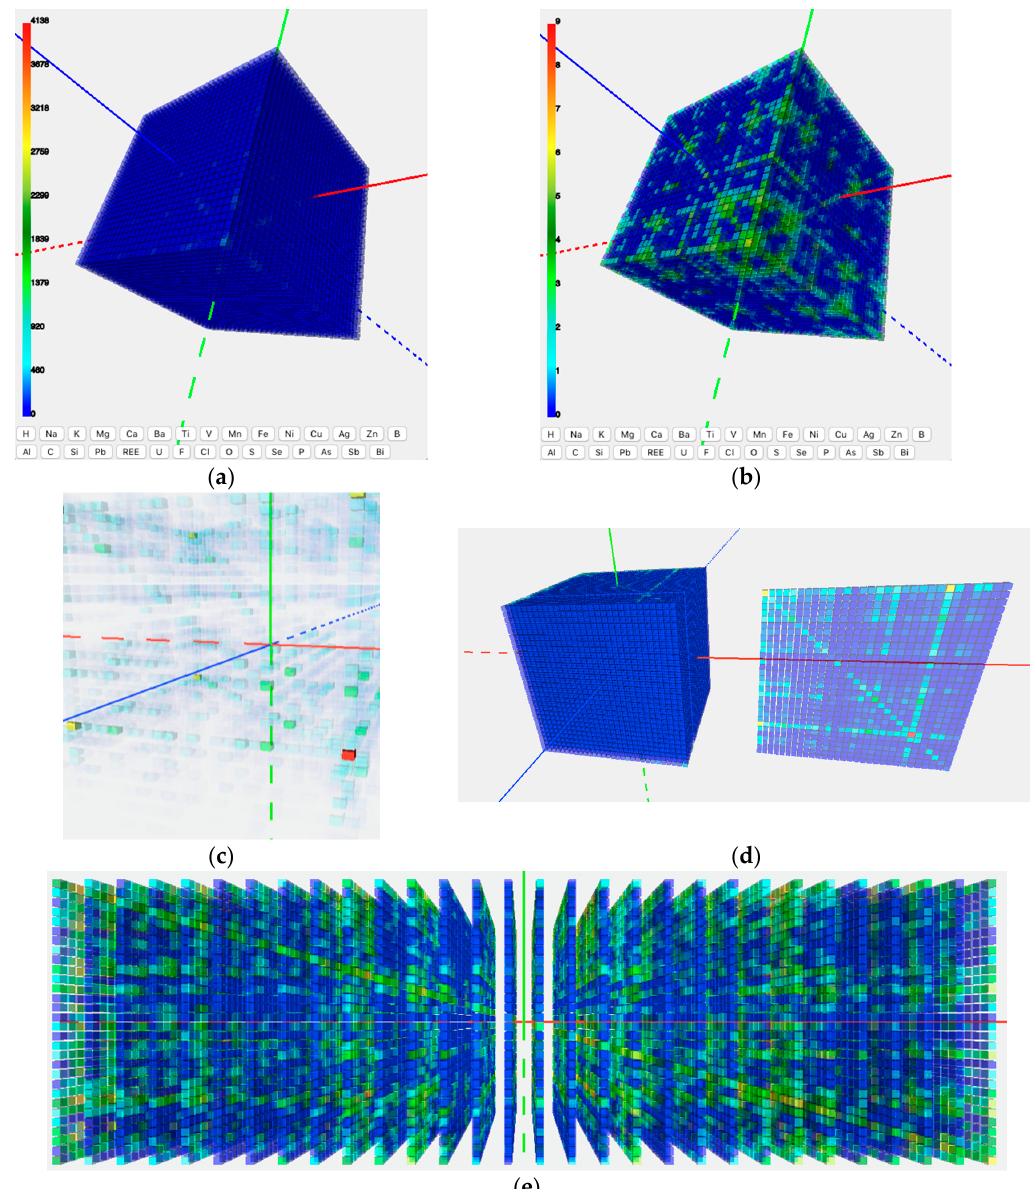
Figure 2. Pilot system for the exploratory data analysis of co-relationships among elements and minerals. ( a ) An initial output by visualizing the raw mineral counts; ( b ) output after taking a logarithmic calculation of the mineral counts in each cell; ( c ) changes in the opacity of each cell based on the value of the mineral counts. The cell filled with solid red (lower right) has oxygen on all three axes. It has the highest mineral count, 4138, in the whole matrix; ( d ) sliced-out two-dimensional planes to see the patterns. Here it shows a plane for oxygen, i.e., oxygen is the element on the Z-axis; and ( e ) changing the distance between cells along one or more axes to see patterns in a two- or one-dimensional context.